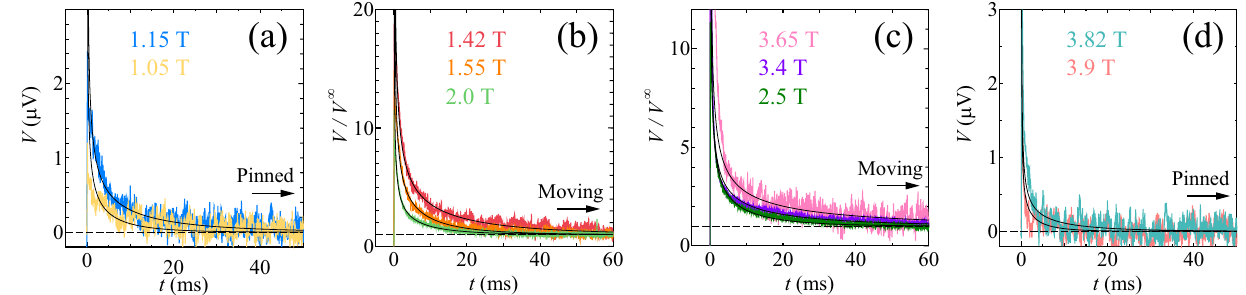
Figure 4. The dynamic disordering of vortices driven by a dc current around the density-driven depinning transition ( B cL 1.27 T) and repinning transition ( B cH 3.8 T). ( a – d ) Voltage responses for the relatively = = ordered initial vortex configuration subjected to the dc current I = 0.375 mA at 4.1 K in different B : ( a ) V ( t ) in B 1.05 and 1.15 T from bottom to top, ( b ) V ( t )/ V ∞ in B 1.42, 1.55, and 2.0 T from top to bottom, ( c ) = = V ( t )/ V ∞ in B 2.5, 3.4, and 3.65 T from bottom to top, and ( d ) V ( t ) in B 3.82 and 3.9 T from top to bottom. = = 0 (pinned phase), ( b ) V ( t )/ V ∞ The horizontal dashed lines mark the steady-state values of ( a ) V ( t ) 1 = = (moving phase), ( c ) V ( t )/ V ∞ 1 (moving phase), and ( d ) V ( t ) 0 (pinned phase). Full lines in ( a – d ) indicate = = the fits to Eq.